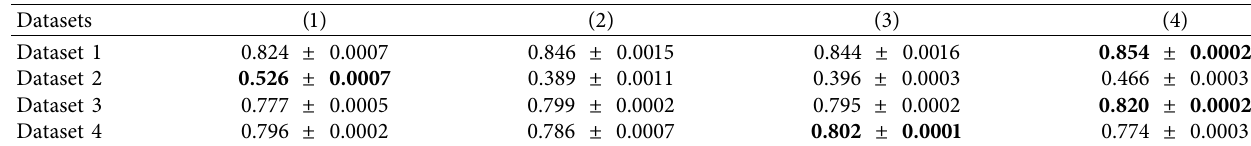
Table 6: The mean accuracy results (with standard deviation) incorporating the mixup method with other methods in 10 runs based on the deep learning model.